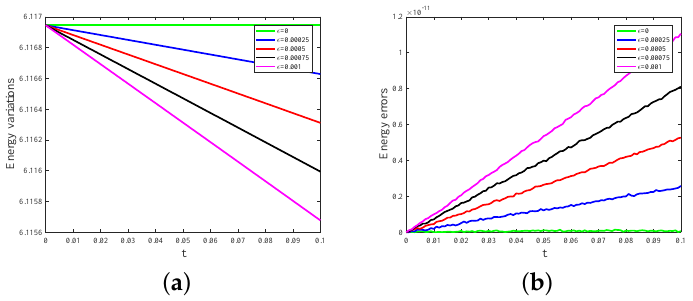
Figure 1. The energy variations ( a ) and energy errors ( b ) of the scheme (15) with various (cid:101)